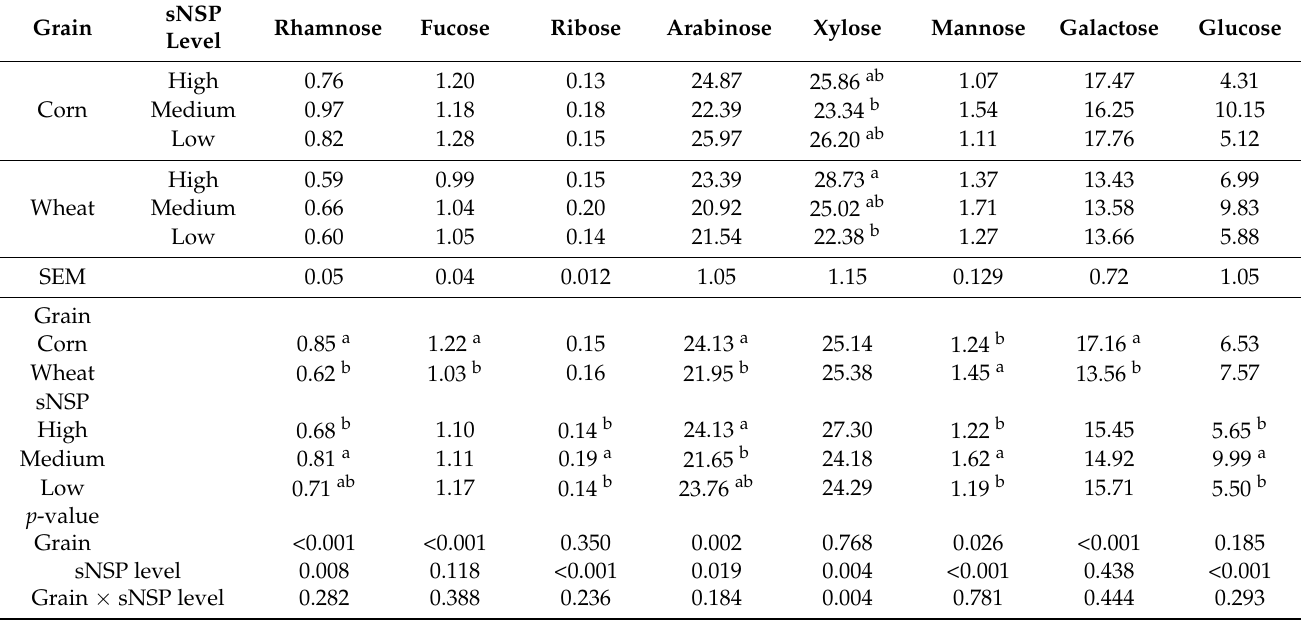
Table 12. Effect of dietary soluble NSP (sNSP) level and grain source on apparent total tract